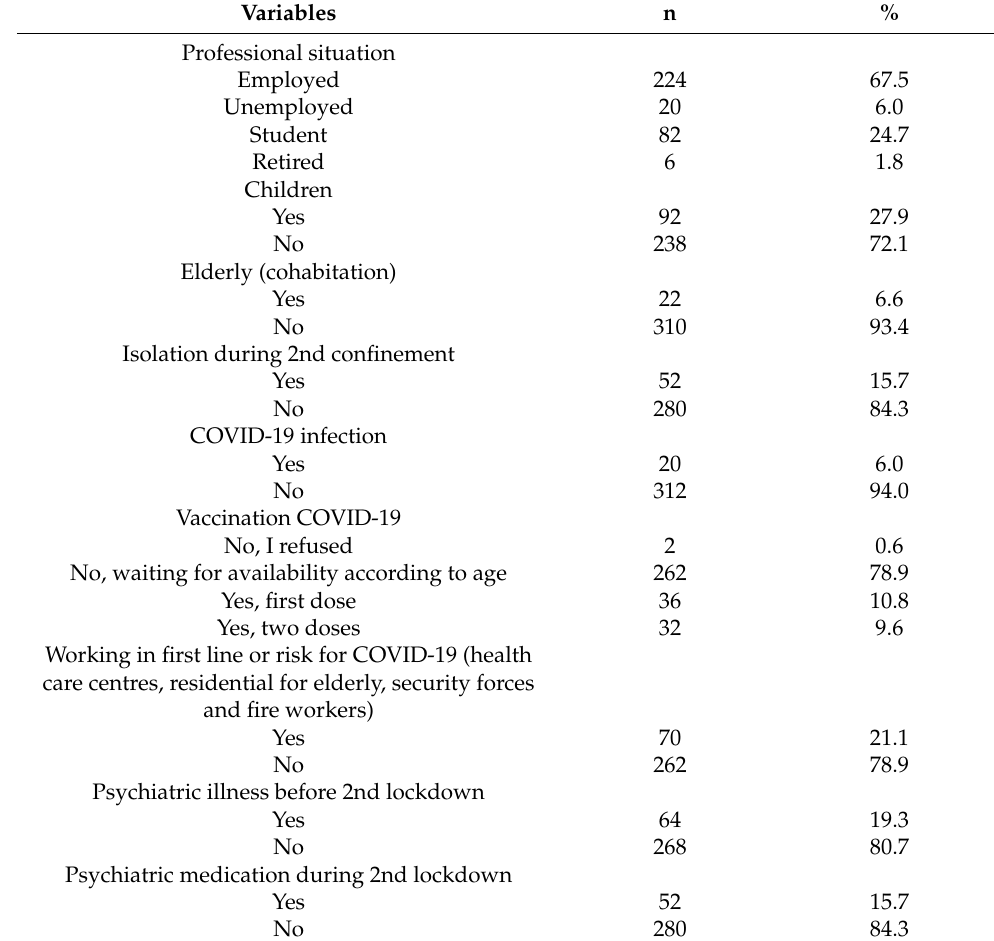
Table 1. Sociodemographic characterization of the sample (N =